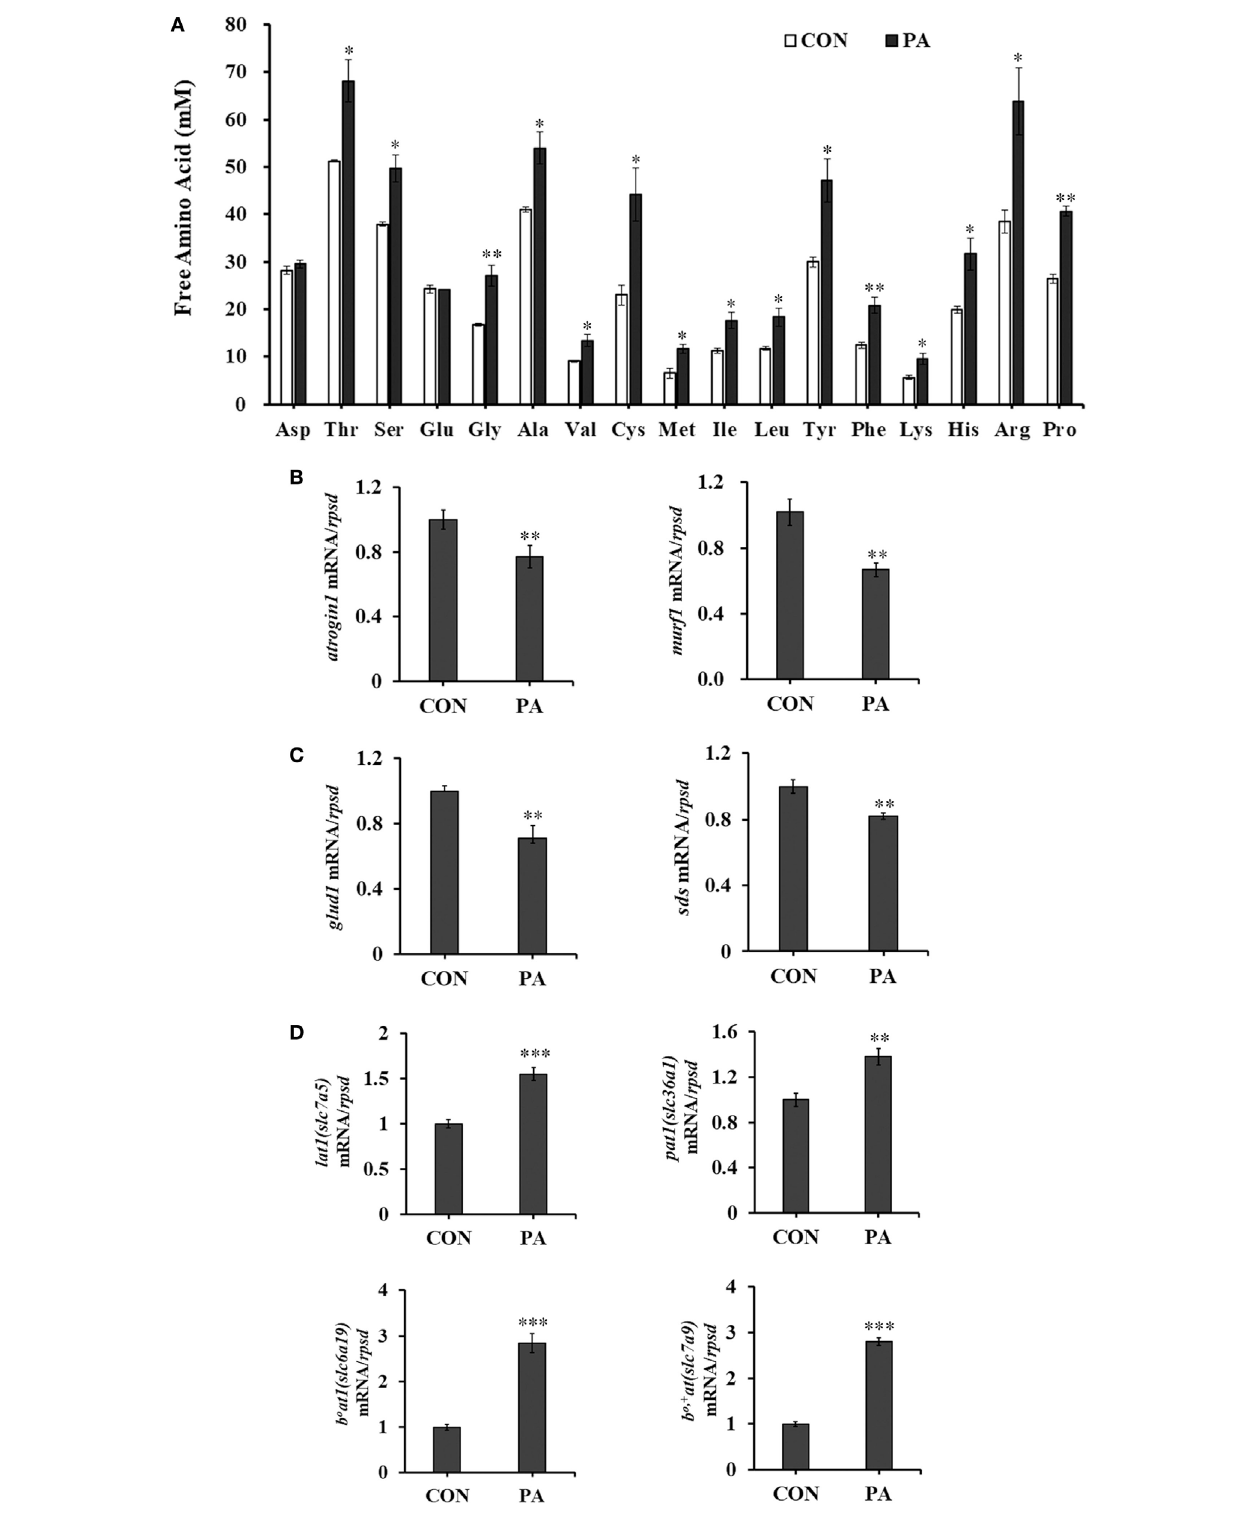
FigUre 5 | Phosphatidic acid (PA) modulated levels of intracellular free amino acids, amino acid transporters, amino acid, and protein catabolism. Serum starved cells were treated with 10 µM PA for 16 h. (a) Intracellular free amino acids concentrations changed after PA treatment ( n = 3). (B–D) The mRNA expressions of atrogin1 , murf1 ; glud1 , sds ; lat1 , pat1 , b 0 at1 , and b 0, + at were analyzed by quantitative real-time PCR after PA treatment ( n = 6). Results were represented as means with SEs and were analyzed using independent t tests (* P < 0.05, ** P < 0.01, *** P < 0.001).